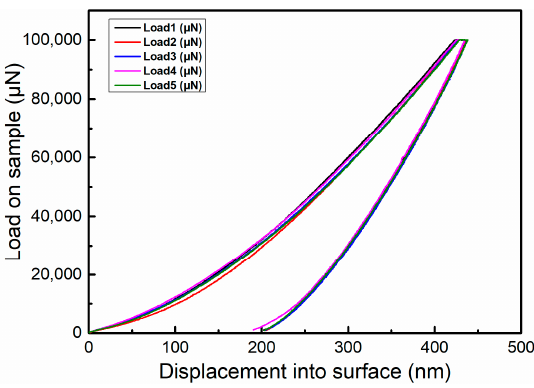
Figure 5. Nano indentation displacement–loading curves of the TiN/Ti coatings.